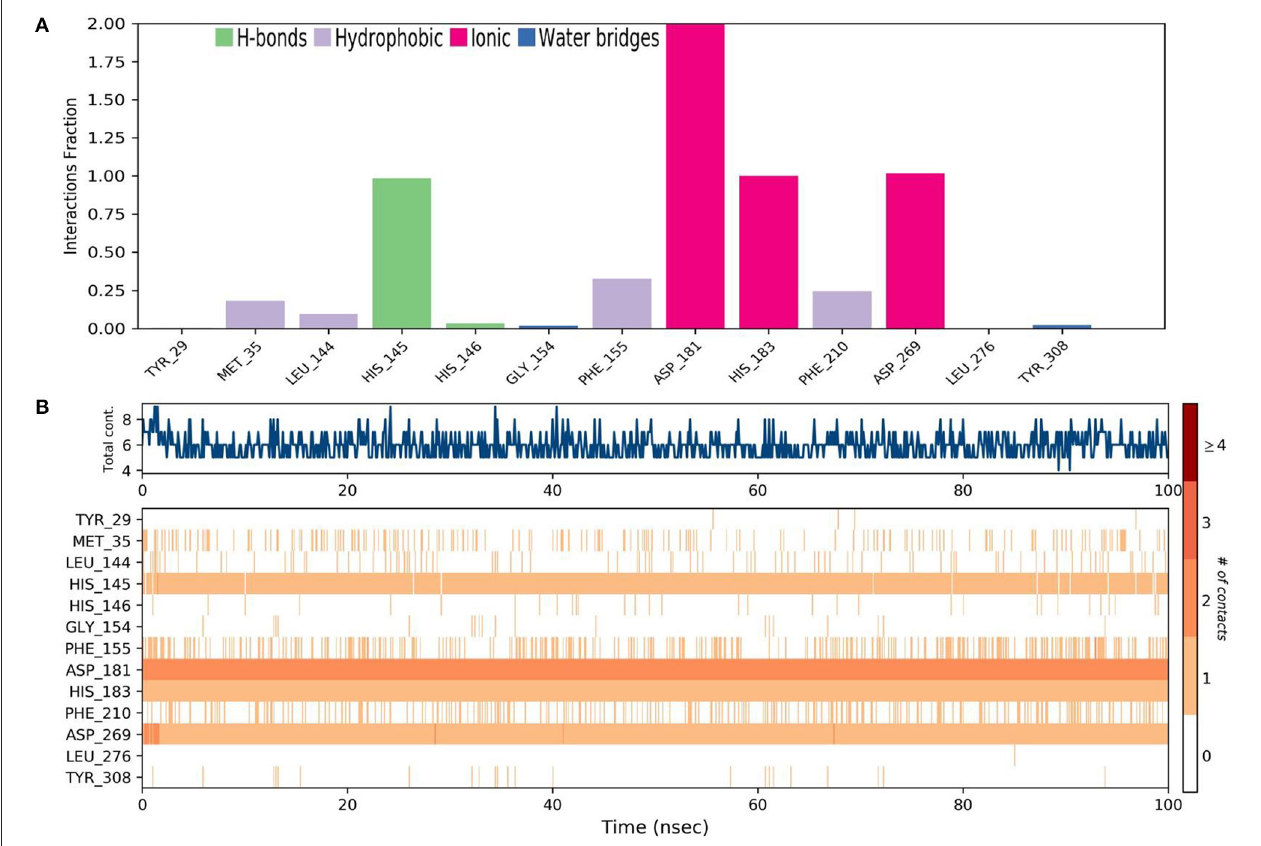
FIGURE 4 | MD simulation analysis of cinnamyl dihydrocinnamate (CMNPD5348) in a complex with HDAC 2 during 100 ns MD simulation time (A) stacked bar chart plot of protein–ligand contact analysis. Abscissa represents the amino acid number and ordinate represents interactions fraction (B) analysis of total contacts timeline analysis of MD trajectory. Darker shades correspond to a higher number of